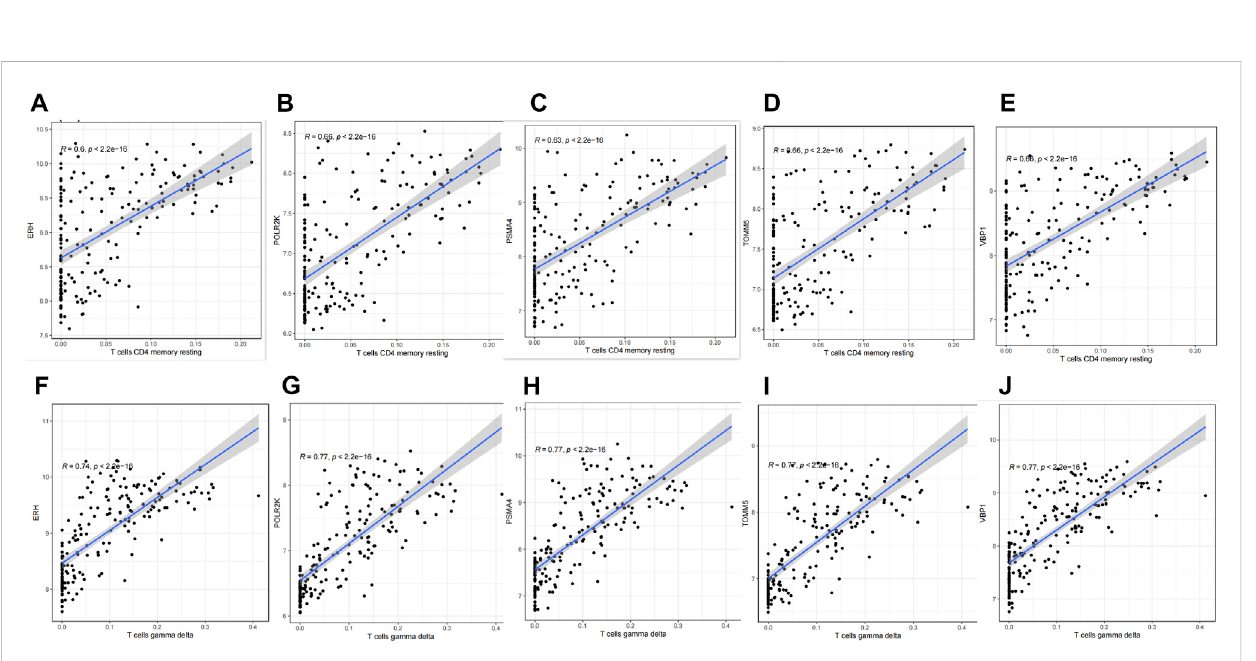
FIGURE 8 Correlation between hub genes and immune cells in fi ltration. (A) ERH & T cell CD4 memory resting. (B) POLR2K & T cell CD4 memory resting. (C) PSMA4 & T cell CD4 memory resting. (D) TOMM5 & T cell CD4 memory resting. (E) VBP1 & T cell CD4 memory resting. (F) ERH & T cell gamma delta. (G) POLR2K & T cell gamma delta. (H) PSMA4 & T cell gamma delta. (I) TOMM5 & T cell gamma delta. (J) VBP1 & T cell gamma